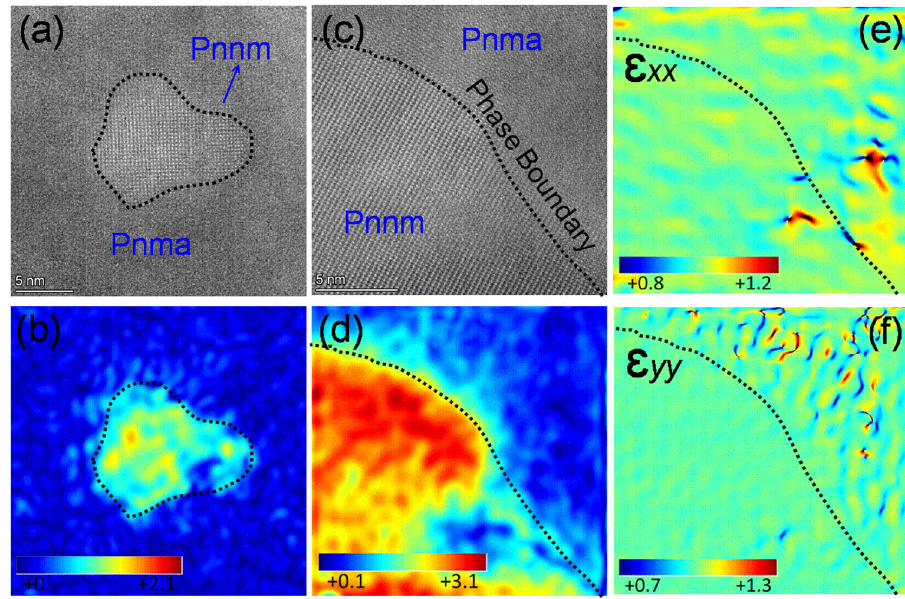
Fig. 4 Geometric phase analysis (GPA) of corresponding HRTEM images from Fig. 3 of Bi 2 Se 1-x Br x S 2 ( x = 0.12). GPA strain maps ( b ) and ( d ) are related to ( a ) and ( c ) and the color bars show the induced strain in the Pnnm phase. e – f Corresponding strain maps along the ɛ xx and ɛ yy directions for ( c